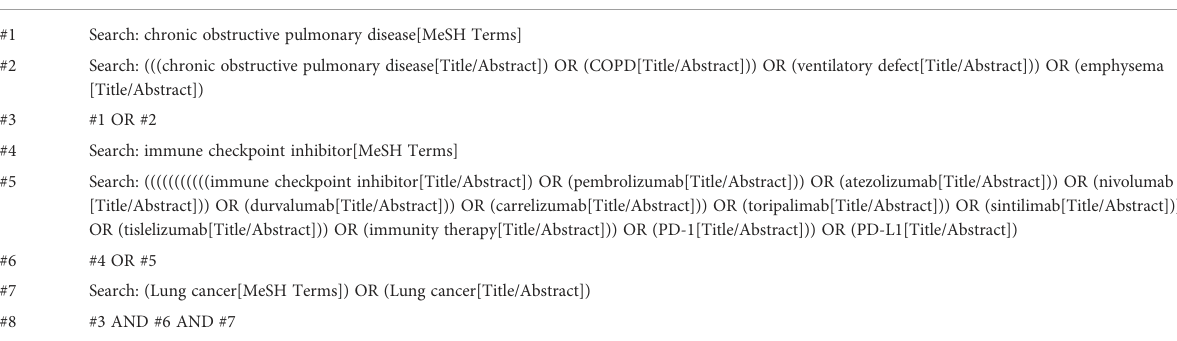
TABLE 1 The search formula of